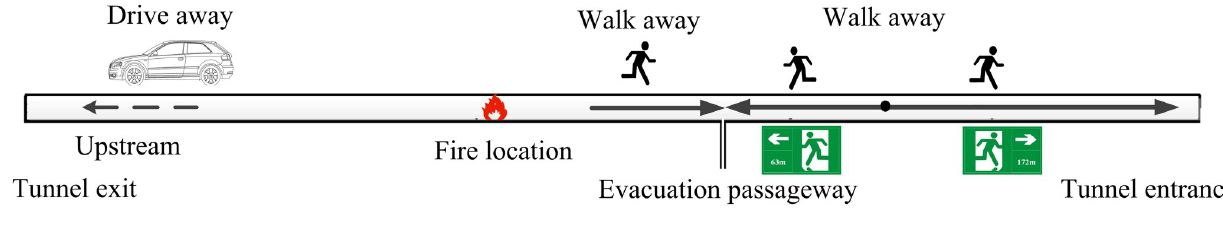
Fig 9. Arrangement of evacuation